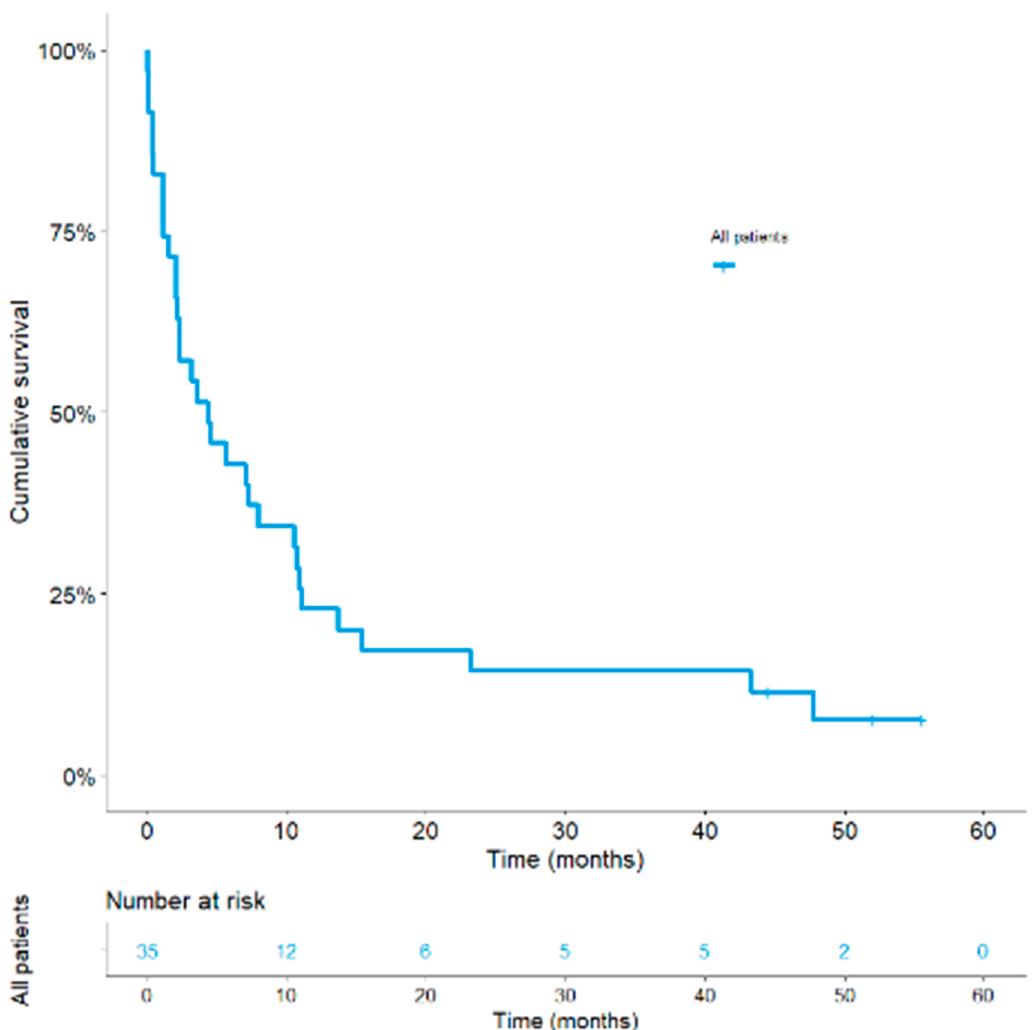
Figure 1. Kaplan–Meier curves of overall survival in the global population. A median four (IQR, 1–7) of nivolumab doses was administered. At data cut-off, two patients were still on treatment. Disease progression was the most common reason for drug discontinuation (54%), followed by death (21%), and then toxicity (12%). Nine patients (26%) were not evaluable for RECISTv.1.1, including one patient with no measurable target lesion and eight who died before disease assessment. For 26 patients evaluable for RECIST v.1.1, 11/26 (42.3%) achieved a partial response, 5/26 (19.2%) had a stable disease as best response, with 10/26 (38.5%) displaying progressive disease. Partial response rate in the intent-to-treat analysis was 32% for the whole series (Supplementary Table S1), whereas in patients with PD-L1 tumor expression ≥ 1%, partial response rate was 39%. No statistically significant differences in objective response were found among PD-L1 subgroups using cutoff values of 1% (Supplementary Table S1) or 50% (no showed). Immunotherapy response median duration in evaluable patients was 16 months (IQR, 46–3) (95% CI, 0–40); individual response durations were plotted in Figure 2, with 7/35 (20%) patients showing response durations that exceeded 9 months. Median PFS was 2.1 months (IQR, 5.7–1.1) (95% CI,